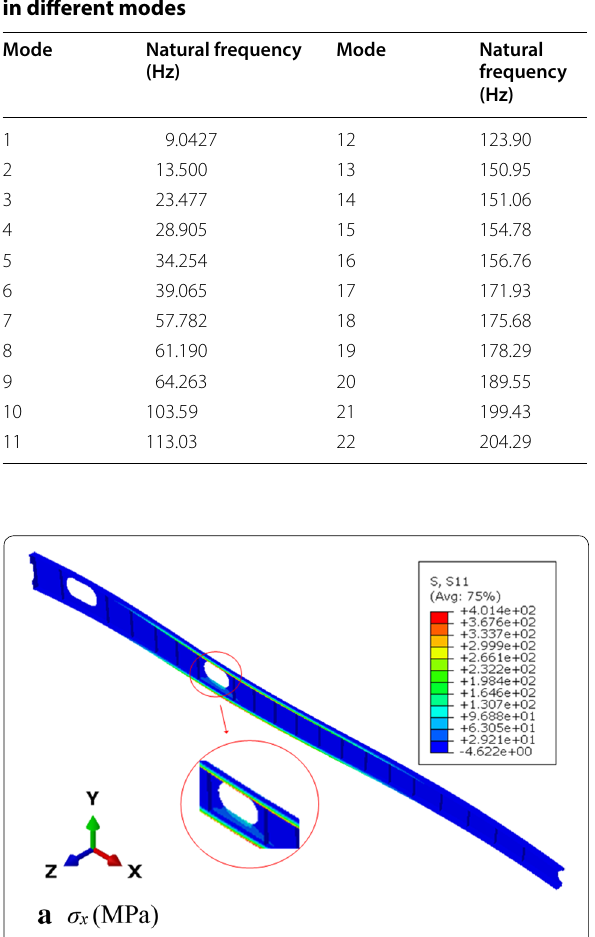
Table 4 σ and U of the first mode of the x max z max